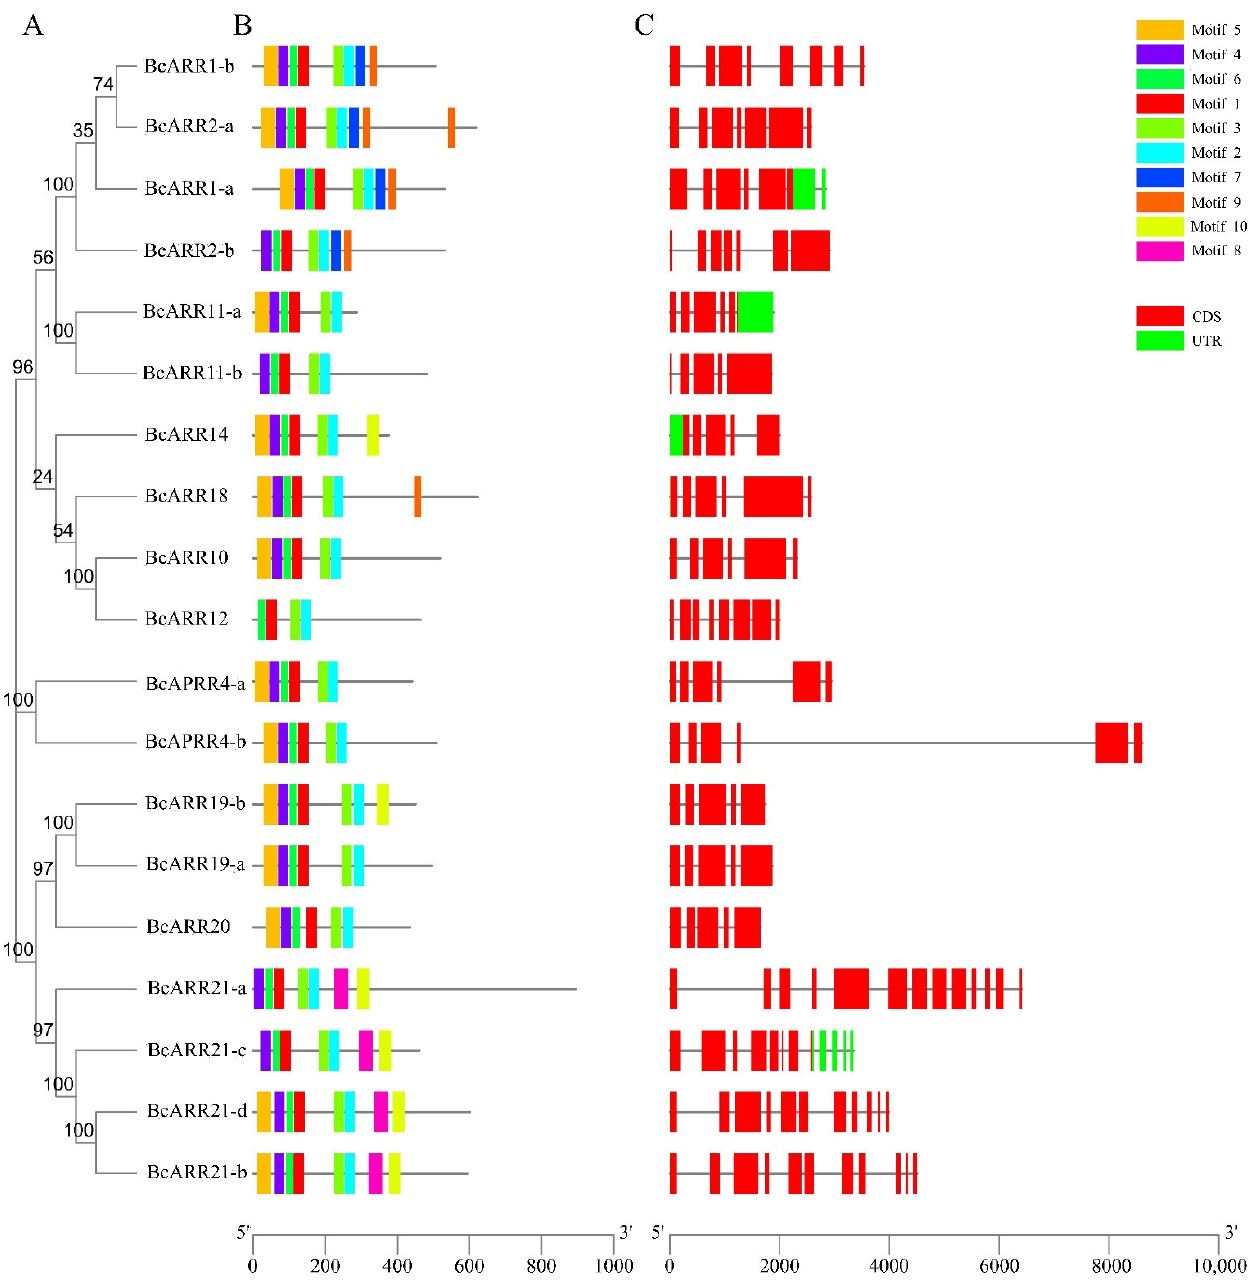
Figure 7. Phylogenetic relationships, gene structure and motif analysis of BcARR-B genes, ( A ) Phylogenetic tree of BcARR-B genes. ( B ) Distribution of conserved motifs in BcARR-B genes; different colors represent the 10 conserved domain identified. ( C ) Gene structure of BcARR-B genes, where red boxes represent CDS and green boxes represent UTR. The lengths of the boxes and lines are scaled according to the length of the genes.